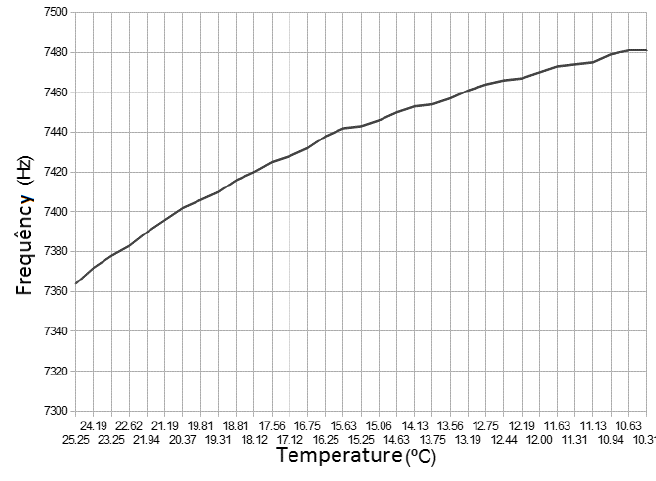
Figure 14. Frequency variation.